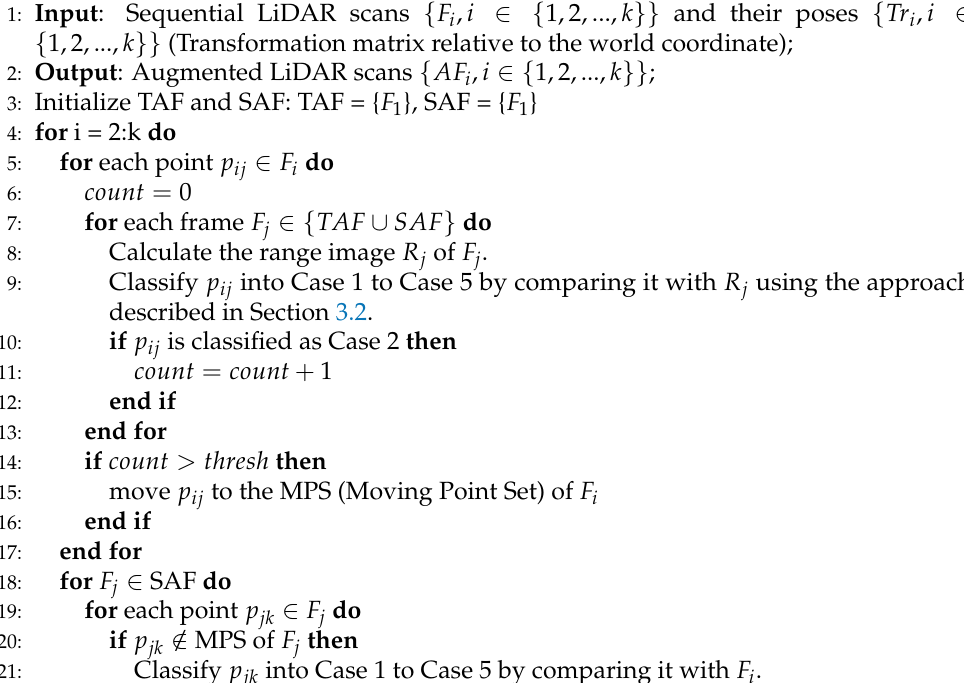
Algorithm 1 LiDAR data enrichment using SAF and